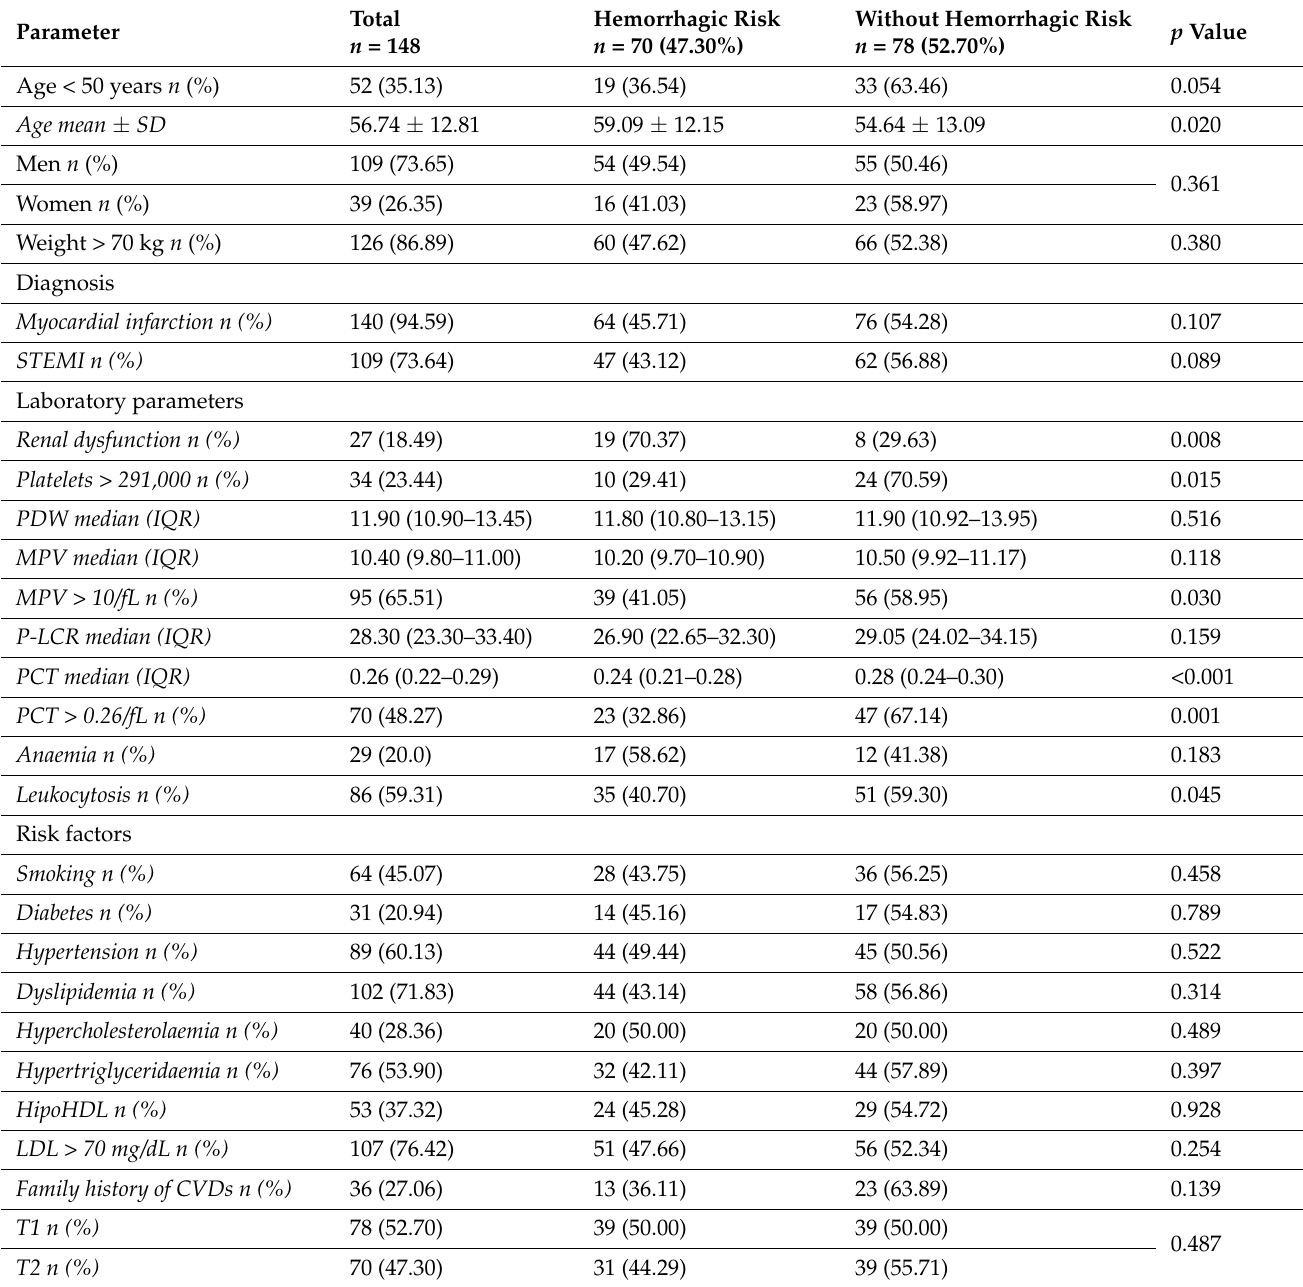
Table 3. Investigated factors related to an elevated hemorrhagic risk * in patients receiving